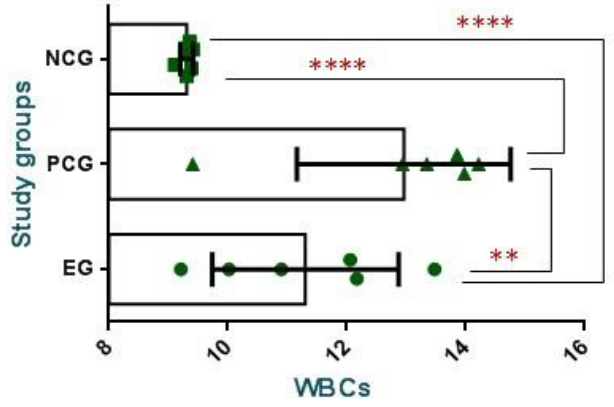
Figure 4. Total results of total WBCs among the experimental groups and the time points. (**) and (****) referred to significant differences between groups as P≤0.01 and P<0.0001 respectively